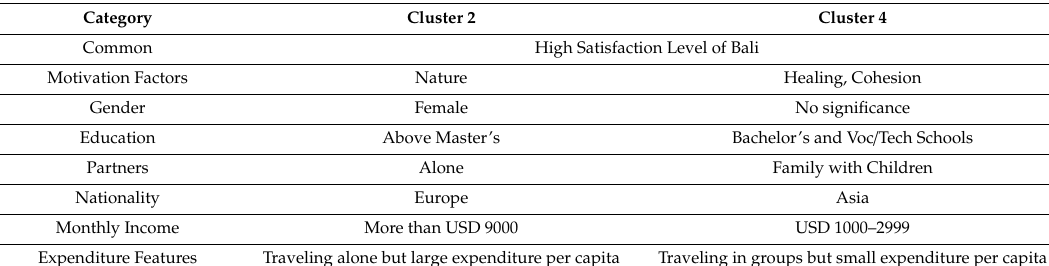
Table 8. Summary of characteristics of Clusters 2 and